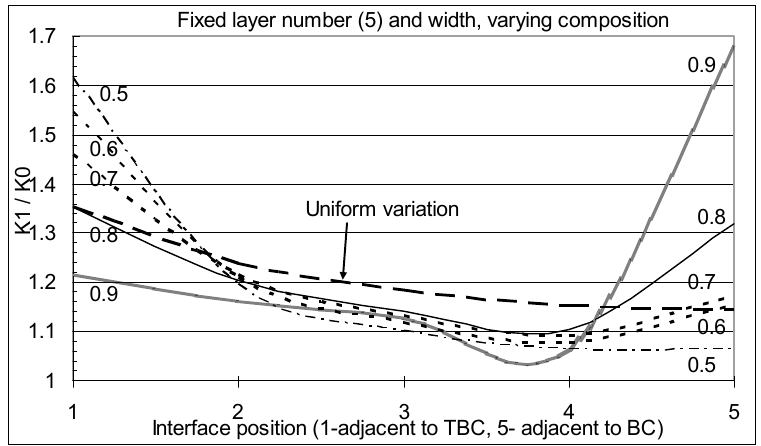
Figure 12. Effect varying composition between adjacent layers while number of layers and thickness is fixed.